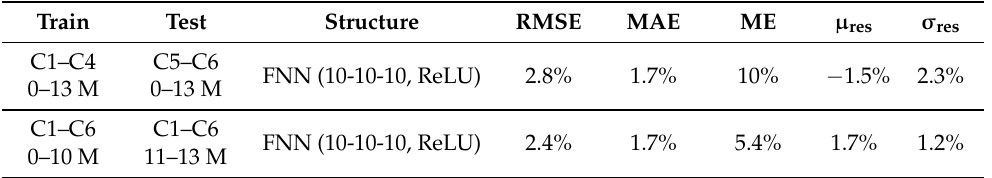
Table 4. Test results with impedance measurements at 10% SoC.